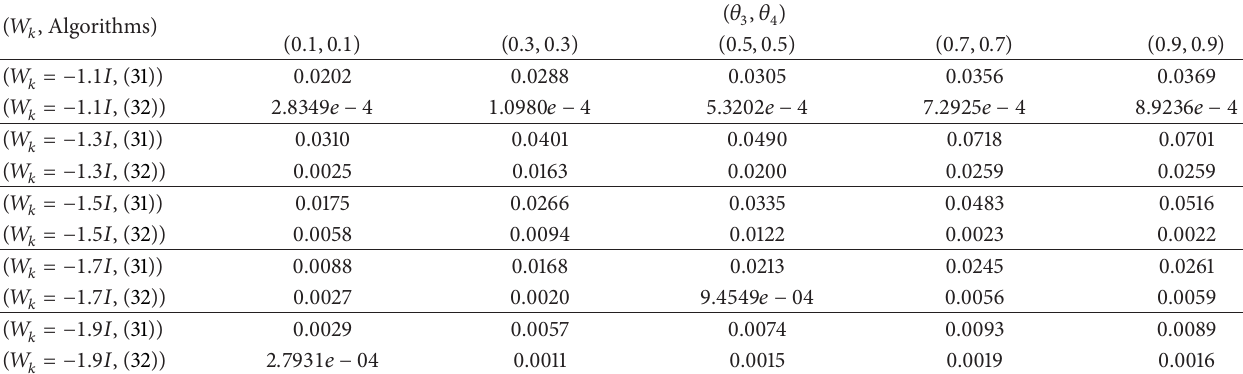
Figure 3: Chaotic attractor of Ikeda-type neural network in Example 14 and the synchronization error of the drive system and response system in Example 14. Table 1: When the impulsive matrix 𝑊 𝑘 is given, sup 𝑘 {𝑡 𝑘 − 𝑡 𝑘−1 } , 𝑘 ∈ N corresponding to different ( 𝜃 3 , 𝜃 4 ) and